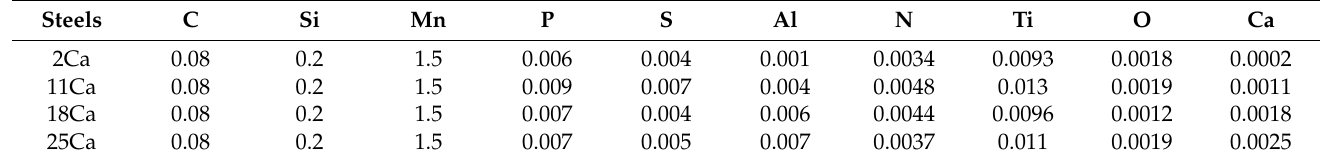
Table 1. Chemical compositions of the HSLA steels with different Ca contents